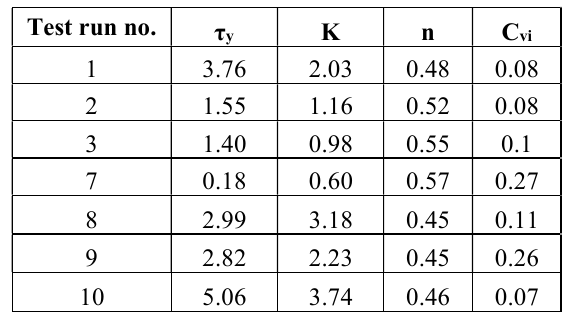
Table 2 . Rheological properties of CBP solutions used for layered model predictions .